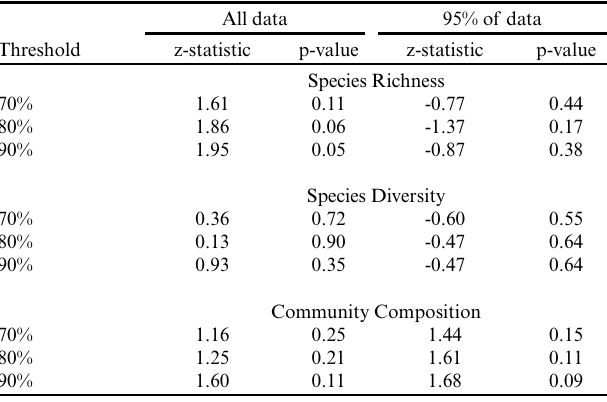
Table 2 . The relationship between greenspace area and the minimum number of checklists necessary to meet 70%, 80%, and 90% threshold levels for 30 greenspaces throughout Canada and the United States (Table A1.1). The summary statistics show no significant relationship between greenspace area and minimum number of checklists both among threshold levels and across separate analyses—(1) the full dataset and (2) those species recorded on > 5% of all checklists at the site—for species richness, species diversity, and community composition (Bray-Curtis